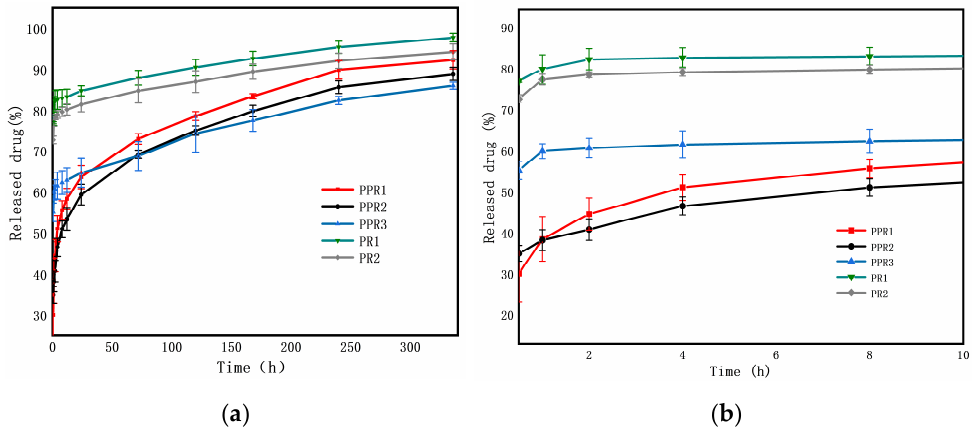
Figure 8. ROX release profiles of coaxial nanofibers PPR1, PPR2 and PPR3, and nanofibers